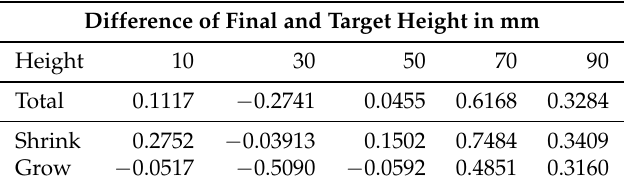
Table 7. Difference from the final mean and target height in mm for height adjustment.